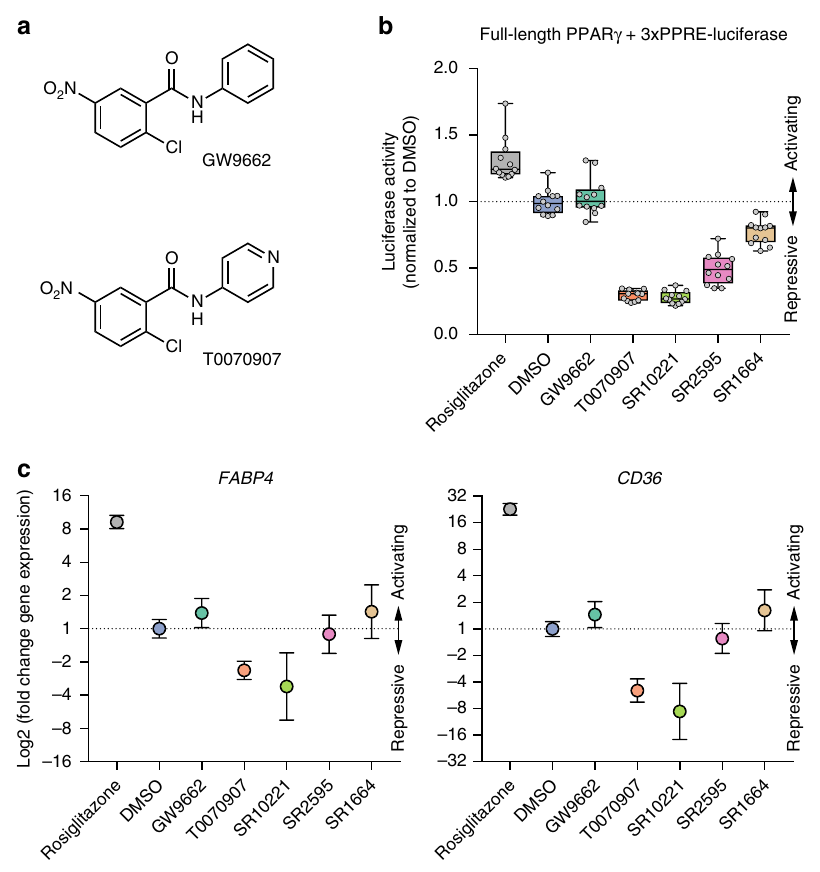
Fig. 1 Cellular pro fi ling of activating, neutral, and repressive synthetic PPAR γ ligands. a Chemical structures of GW9662 and T0070907. b Cell-based full- length PPAR γ luciferase transcriptional assay showing the effect of activating, neutral, and repressive PPAR γ ligands (5 µ M) on full-length PPAR γ transcription in HEK293T cells. Individual points ( n = 12) normalized to DMSO control (mean) are plotted as white circles on top of a box-and-whiskers plot; the box represents 25th, median, and 75th percentile of the data, and the whiskers plot the entire range of values. c Relative quantitation of fold change in PPAR γ target gene expression determined by qPCR normalized to TBP expression of 3T3-L1 cells treated with transcriptionally activating, neutral, or repressive PPAR γ ligands (10 µ M), plotted as relative log2 of data calculated using the 2 - ΔΔ Ct method ( n = 3) with error bars representative of the upper and lower limits. Data are representative of at least 3 independent